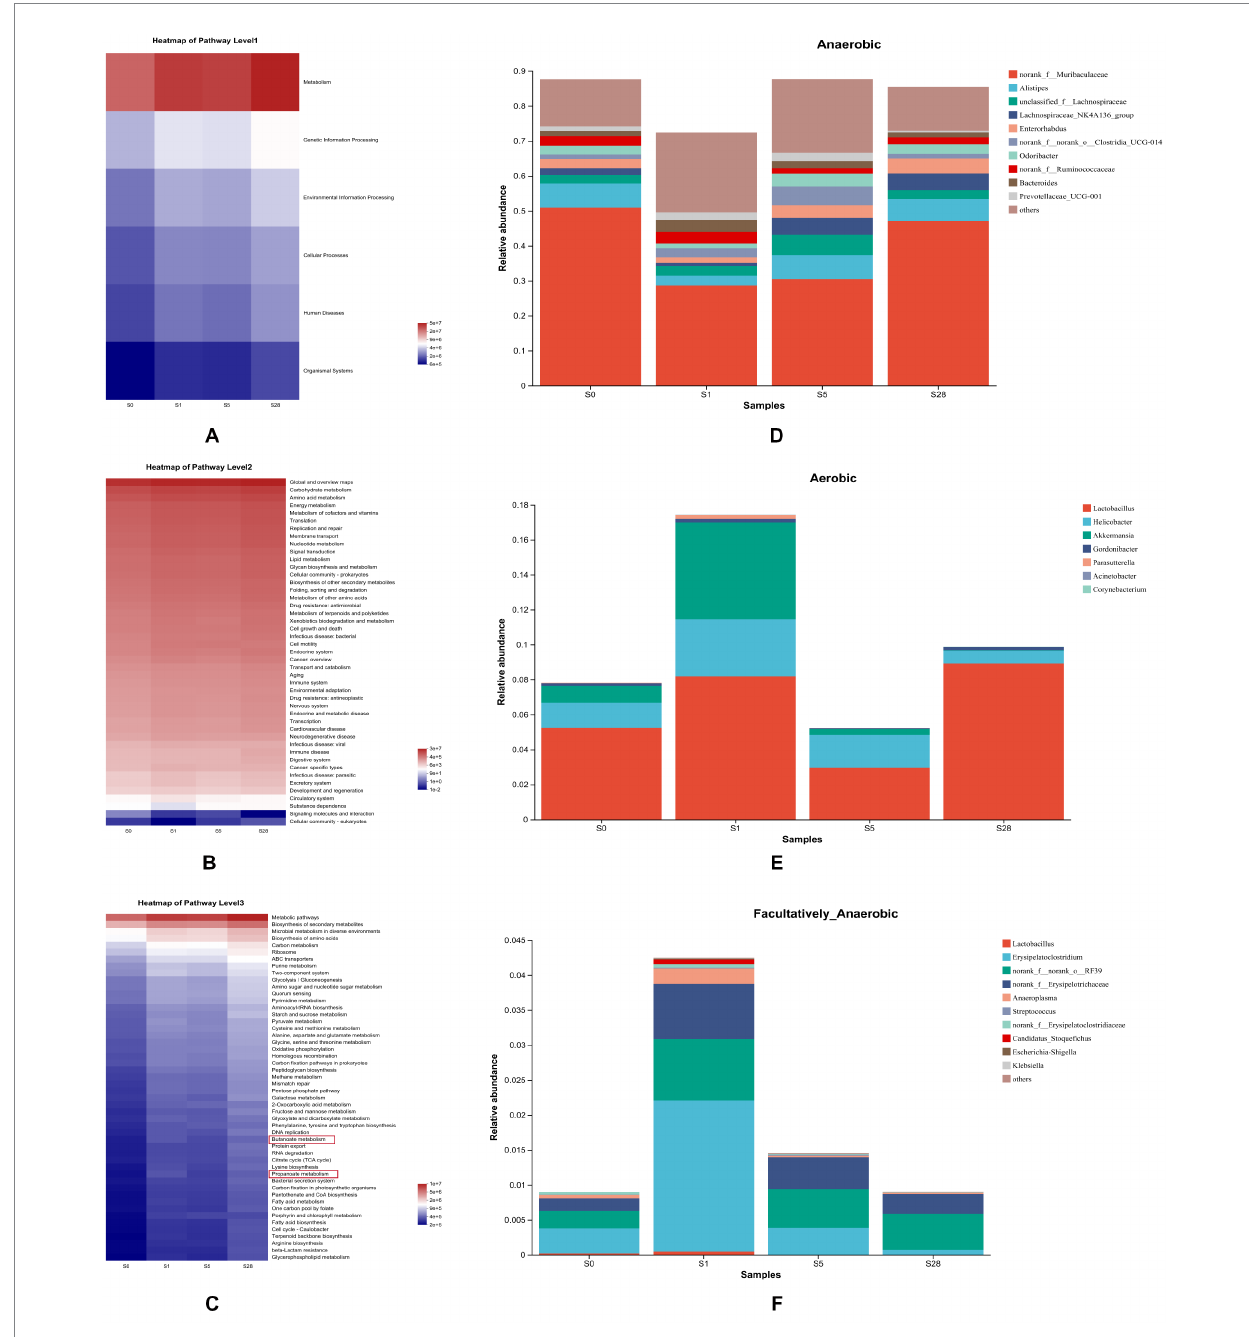
FIGURE 5 Analysis of microbial gene function prediction and dominant species contribution. Heatmap of pathways at level 1 (A) , level 2 (B) , and level 3 (C) determined in the KEGG pathway database. The color patch gradient is used to show the abundance change of different functions in the samples, and the legend provides a representation for the color gradient value. BugBase for anaerobic (D) , aerobic (E) , and facultatively anaerobic (F) , at the genus level. Each color represents a different species, and the ordinate is the contribution degree of every bacterium to this